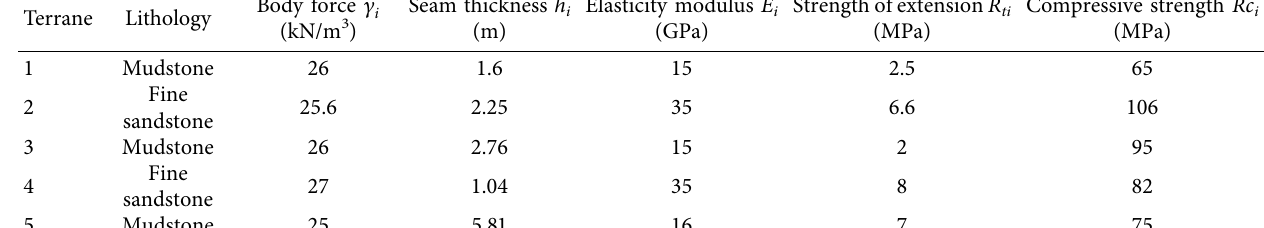
Table 2: Lithology and physical and mechanical parameters of the roof of the entry.